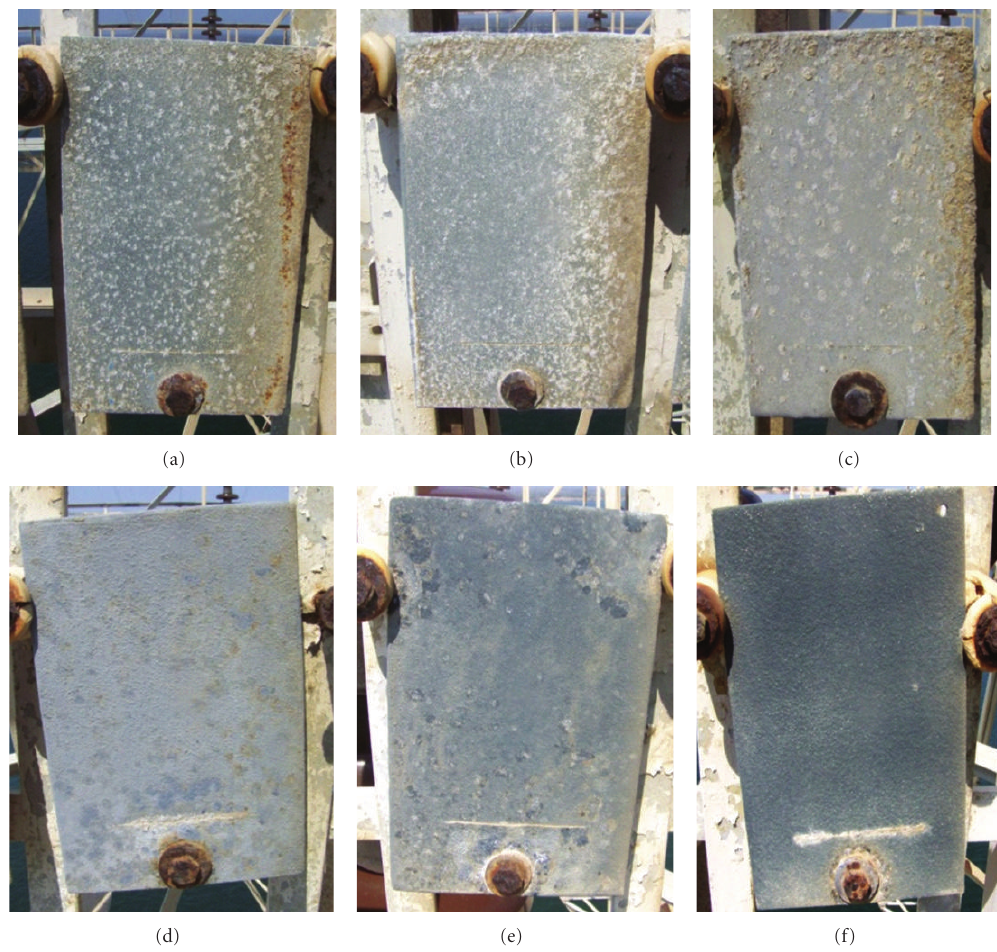
Figure 9: Comparison of di ff erent sealed systems used at the LMC Station, after 41 months of exposure (a) Thermal sprayed coating of zinc by flame process (wire), sealed with wash primer 1 (173 μ m). (b) Thermal sprayed coating of zinc by the electric arch process, sealed with wash primer 1 (264 μ m). (c) Thermal sprayed coating of zinc by electric arch process, sealed with phenolic (261 μ m) (66 months of exposure). (d) Thermal sprayed coating of aluminum by electric arch process with phenolic (261 μ m). (e) Thermal sprayed coating of aluminum by electric arch process, sealed with wash primer 1 (251 μ m). (f) Thermal sprayed coating of Zn/Al by the flame process, sealed with wash primer 1 (345 μ m).